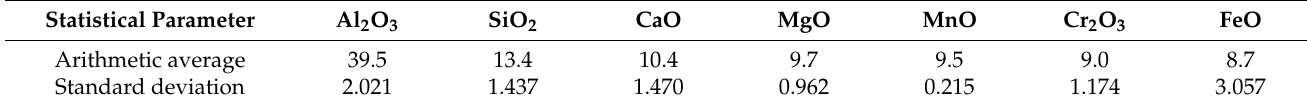
Table 4. Non-metallic inclusion phase structure (vol.